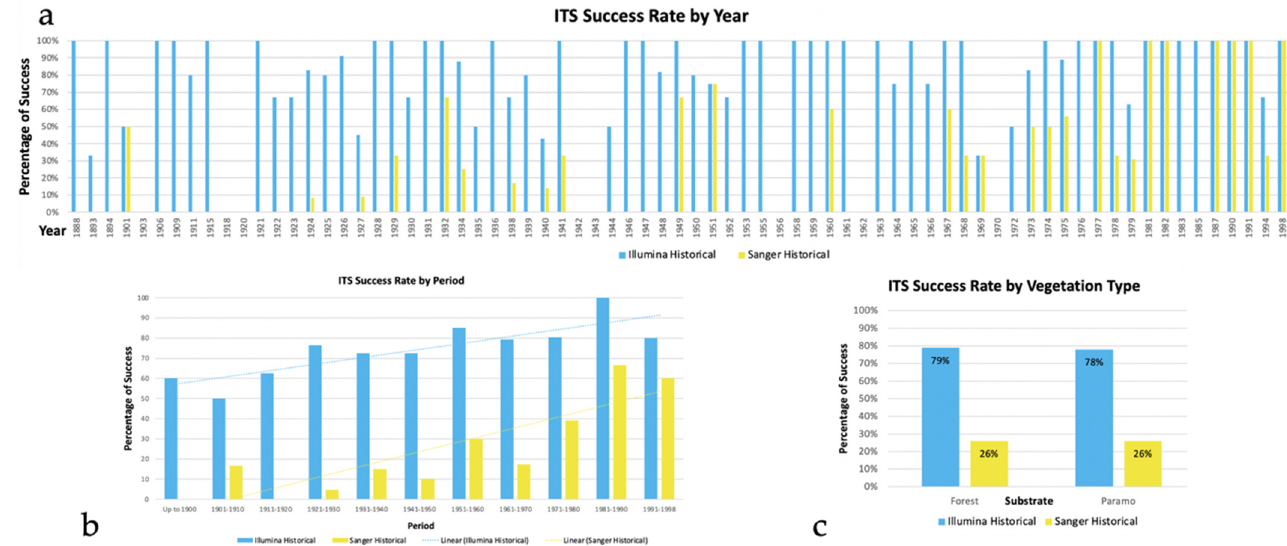
Figure 4. Percentage of success in sequencing historical samples between the two tested sequencing platforms (Illumina, Sanger) by year ( a ), by period of time ( b ), and vegetation type ( c ).